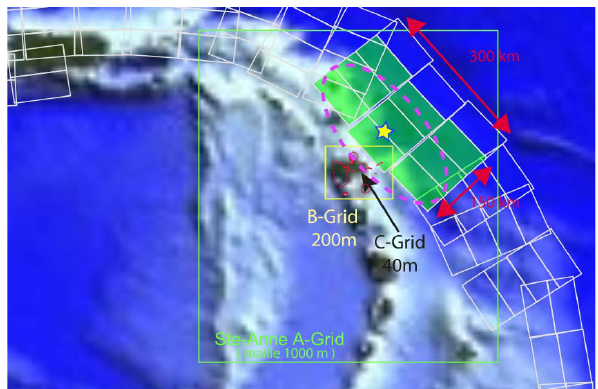
Fig. 3. Area of the 1843 rupture zone and possible epicenter location (yellow star) as proposed by Feuillet et al. (2011) within the north- ern Lesser Antilles (pink dashed line). The green rectangles rep- resent the available pre-defined patches of ComMIT matching the proposed rupture zone. The geographical extents of grids A (north- ern Lesser Antilles grid), B (Guadeloupe Archipelago grid) and C (Sainte-Anne or Saint-Franc¸ois grids) introduced in ComMIT are highlighted with empty